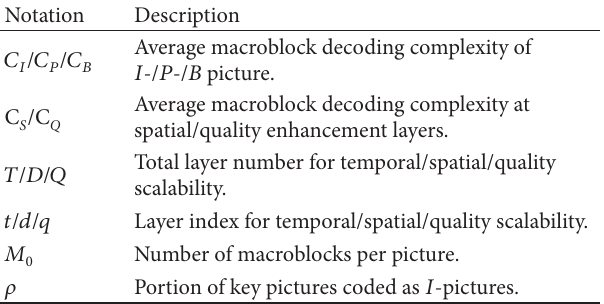
Table 2: Symbols for analytical complexity model.